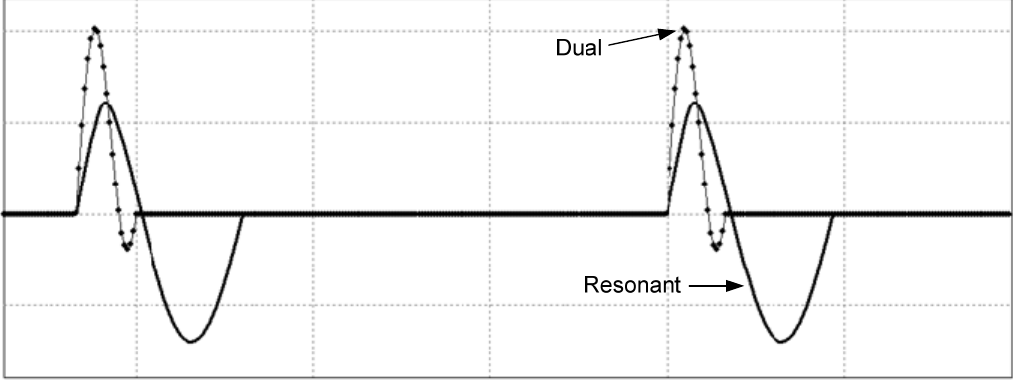
Figure 3. Typical auxiliary inductor current waveforms for ZVS-PWM boost converters operating with input voltage V P = 2 kW, and switching frequency f o